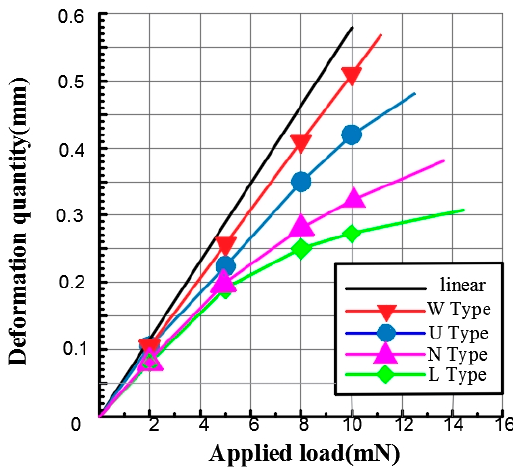
Figure 4. Nonlinear simulation curves of four kinds of structural springs.